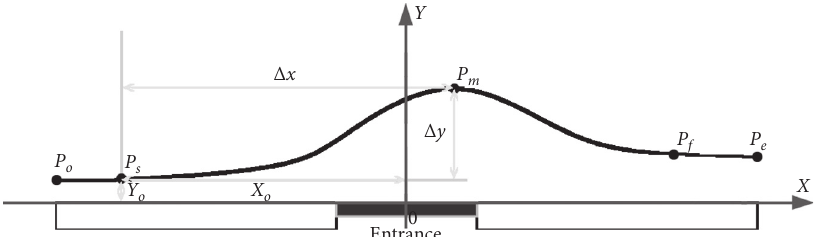
Figure 1: Key points of passing